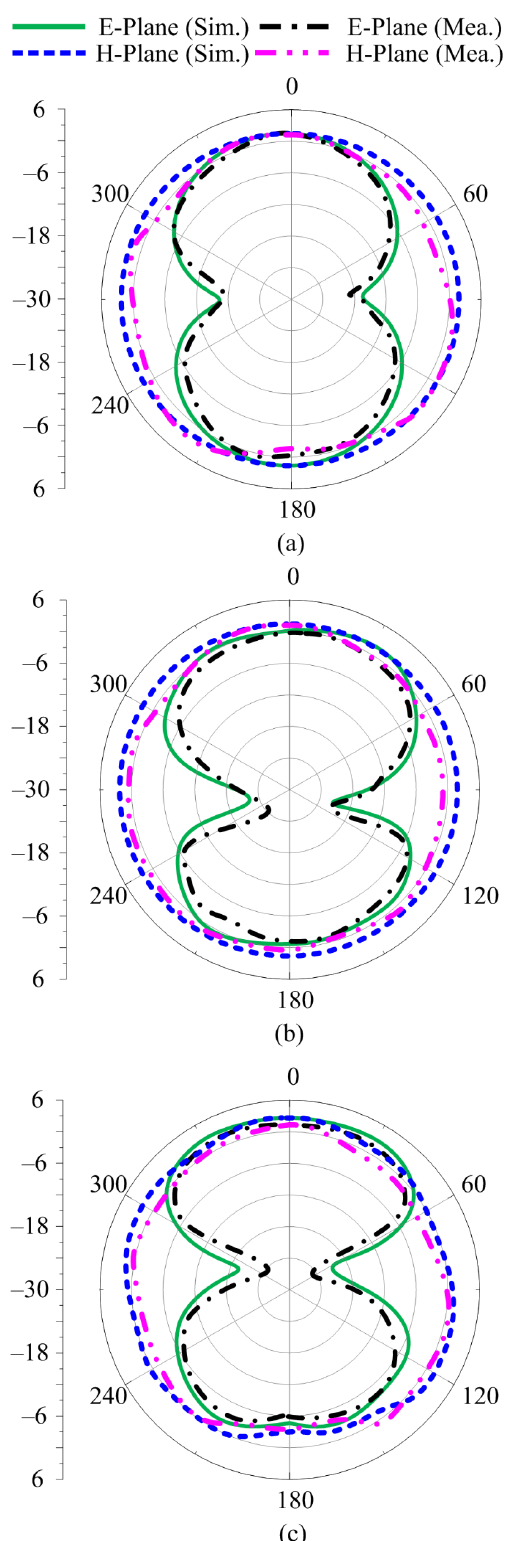
Figure 11. Comparison of predicted and measured radiation patterns at ( a ) 3.5 GHz, ( b ) 6.8 GHz, and ( c ) 9 GHz.